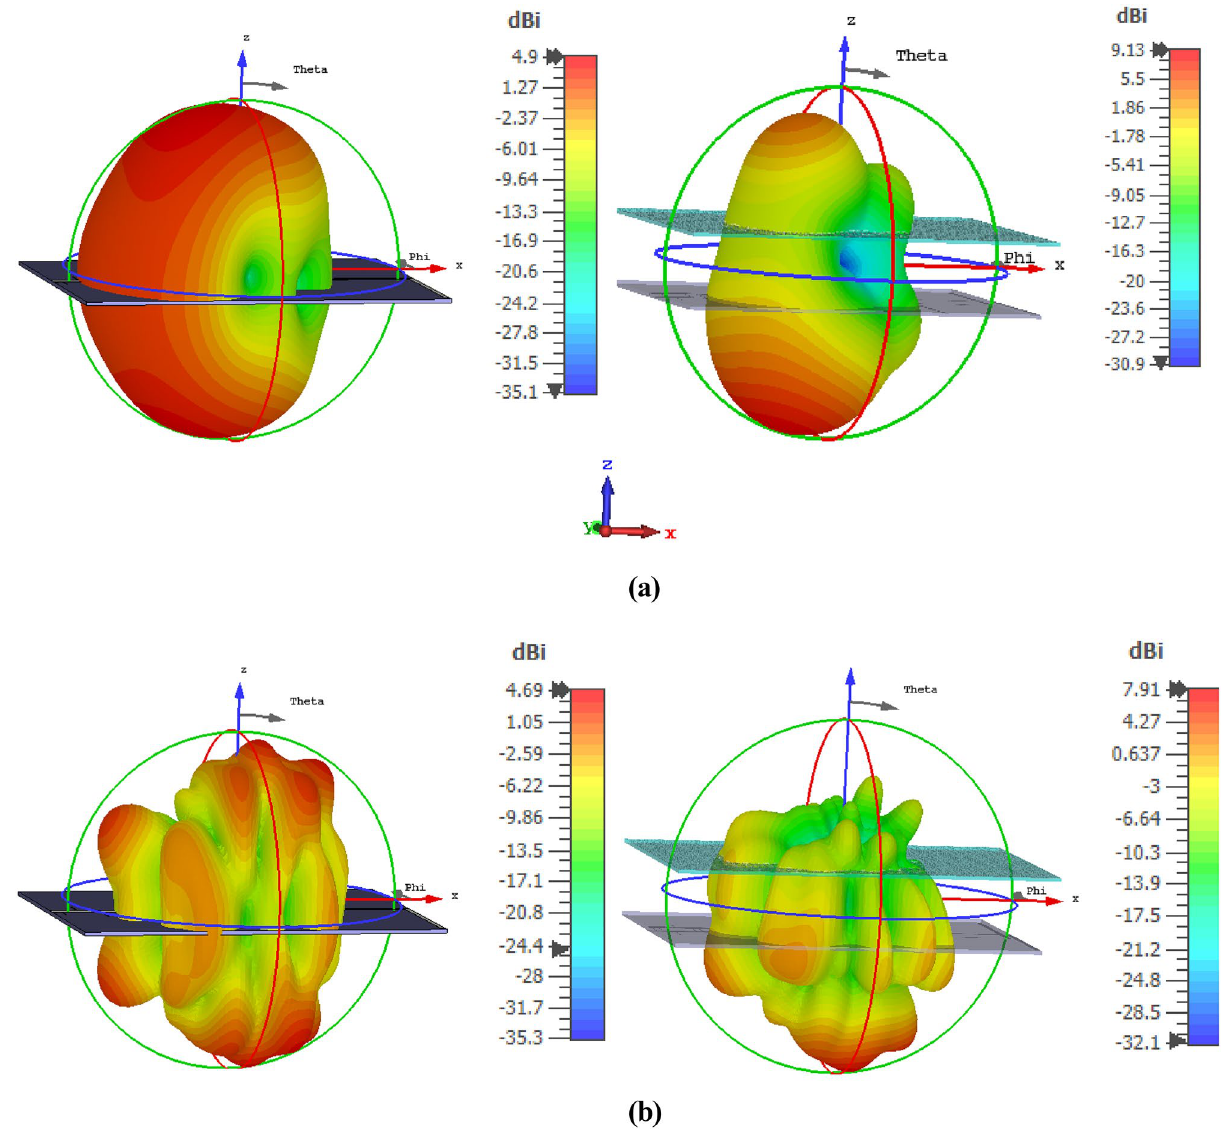
Figure 34. The far-field 3D radiation pattern of with and without NZI MTM cover of the TLPD antenna ( a ) 2.38 GHz and ( b ) 6.08